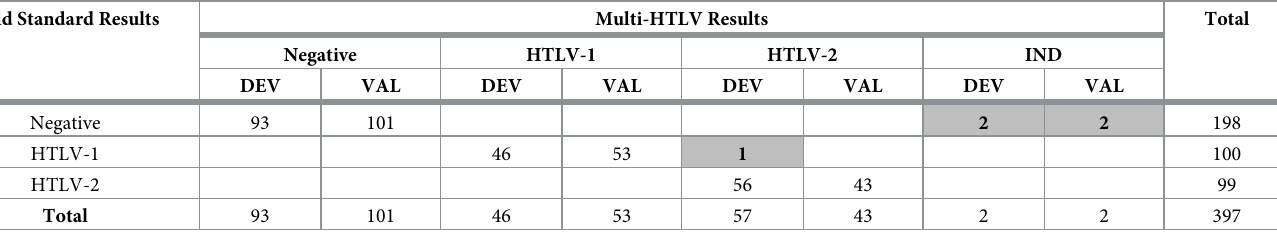
Table 3. Analysis of the Multi-HTLV results on the HOST cohort.